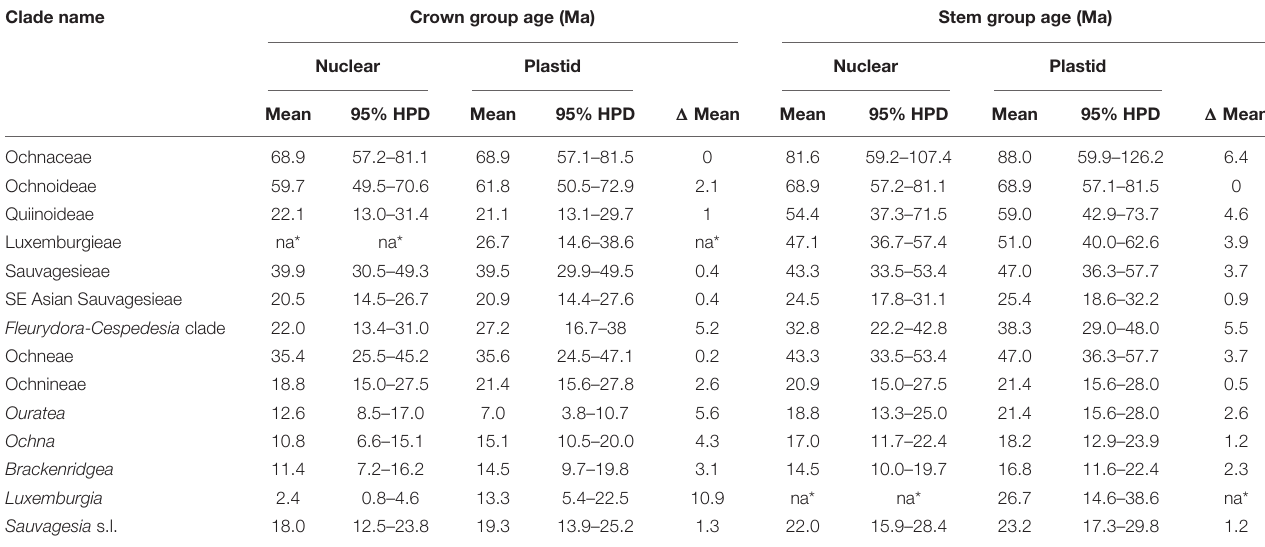
TABLE 1 | Crown and stem group ages of major clades of Ochnaceae as inferred from divergence time estimation (i.e., the maximum clade credibility trees with mean heights obtained from BEAST analysis) based on nuclear and plastid genomic